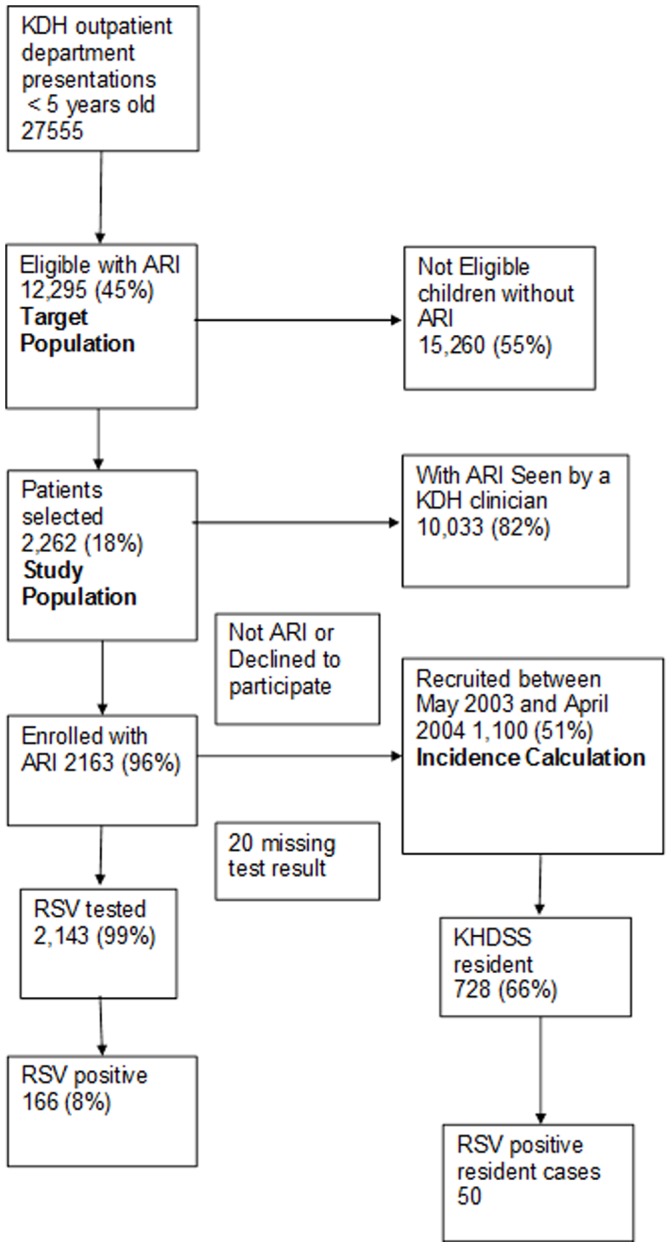
Flow diagram of recruitment and sample testing of children aged under 5 years presenting to Kilifi District Hospital from May 2002 to April 2004.